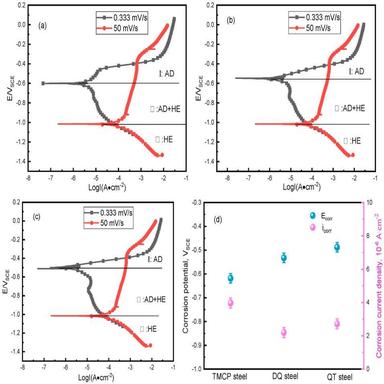
Potentiodynamic polarization curves of three kinds of Ni-advanced steel with different scanning rates (a) TMCP steel, (b) DQ steel, (c) QT steel, (d) Ecorr and Icorr.